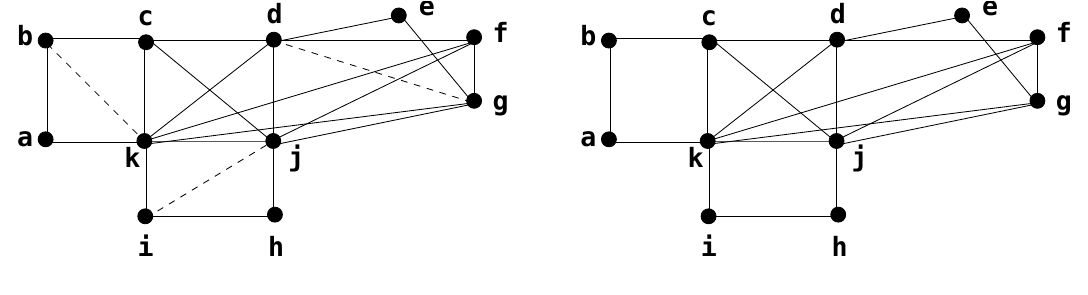
Figure 5. H is a minimal triangulation of G . The fill edges are represented by dotted